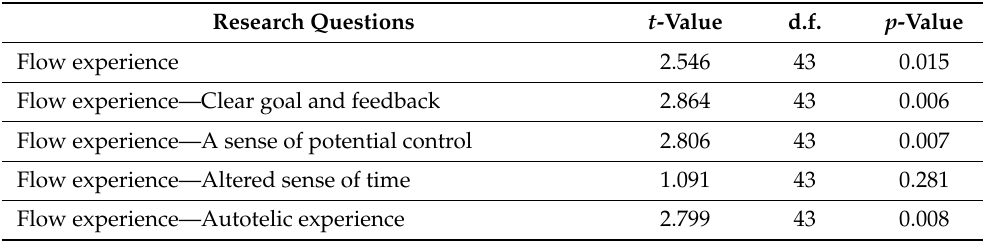
Table 6. Hypothesis testing of paired t -test results related to flow experience, learning motivation, learning interaction, self-efficacy, and